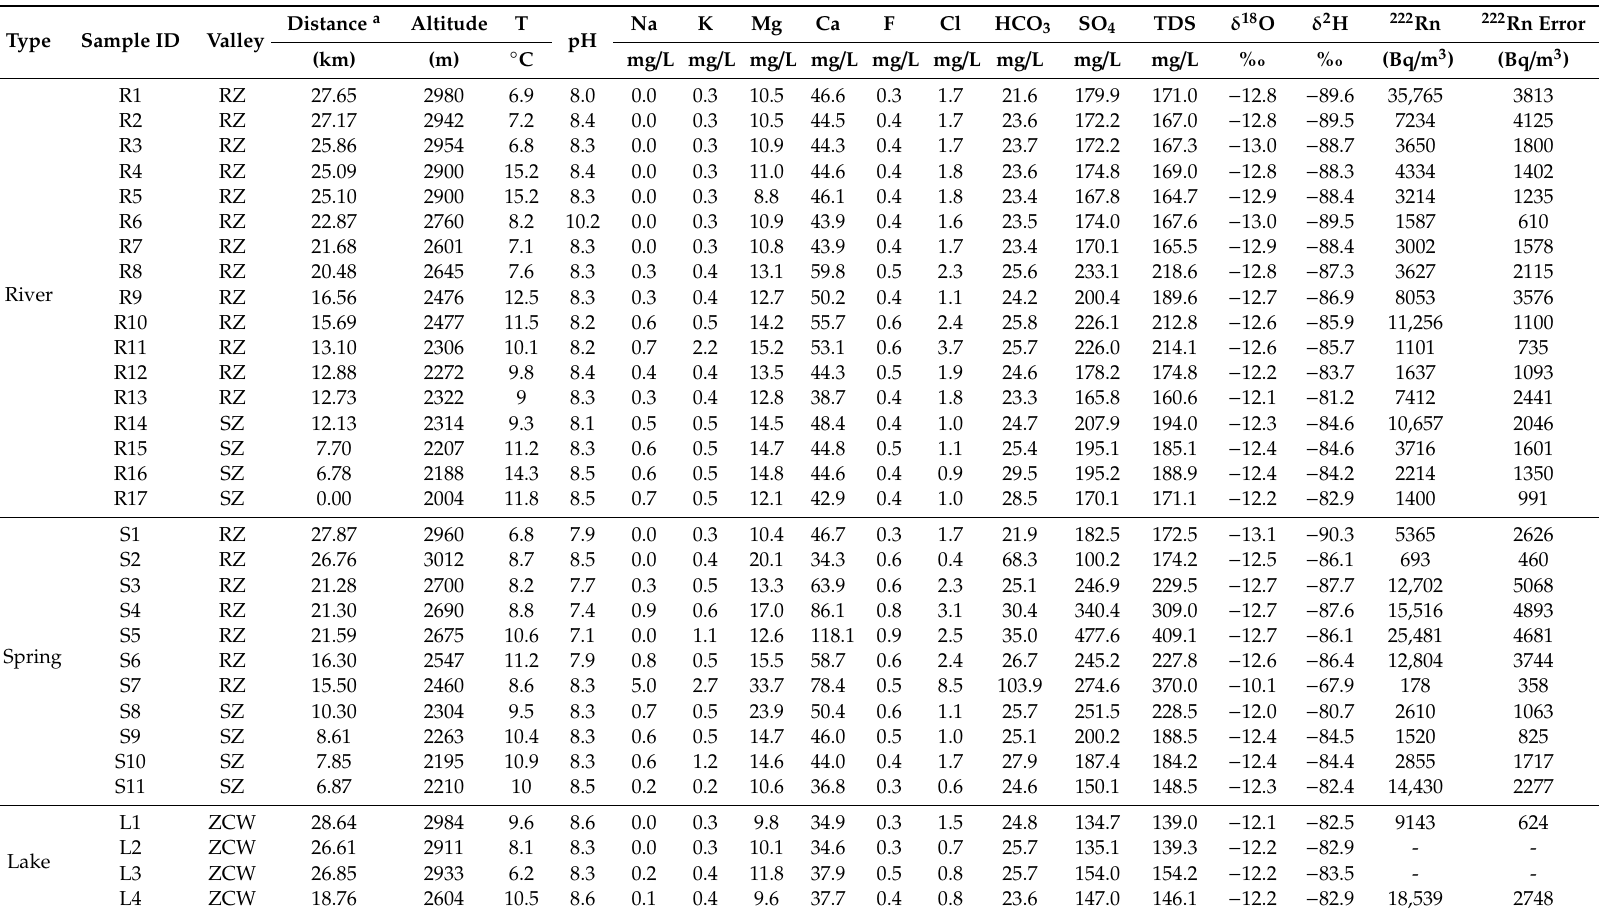
Table 1. Field parameters, major ions, and water